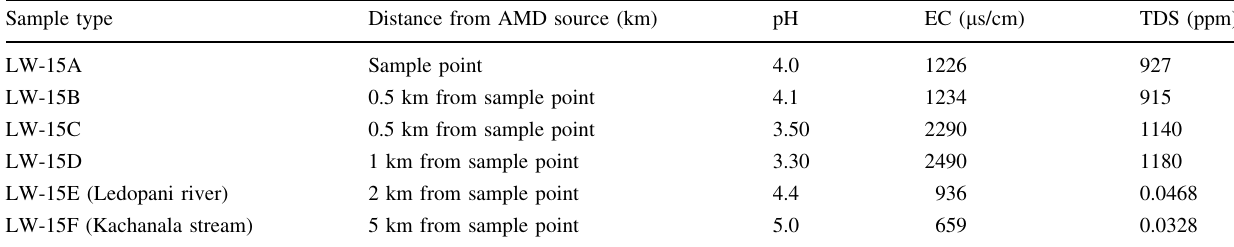
Table 2 Geochemical analysis of mine water samples Sample